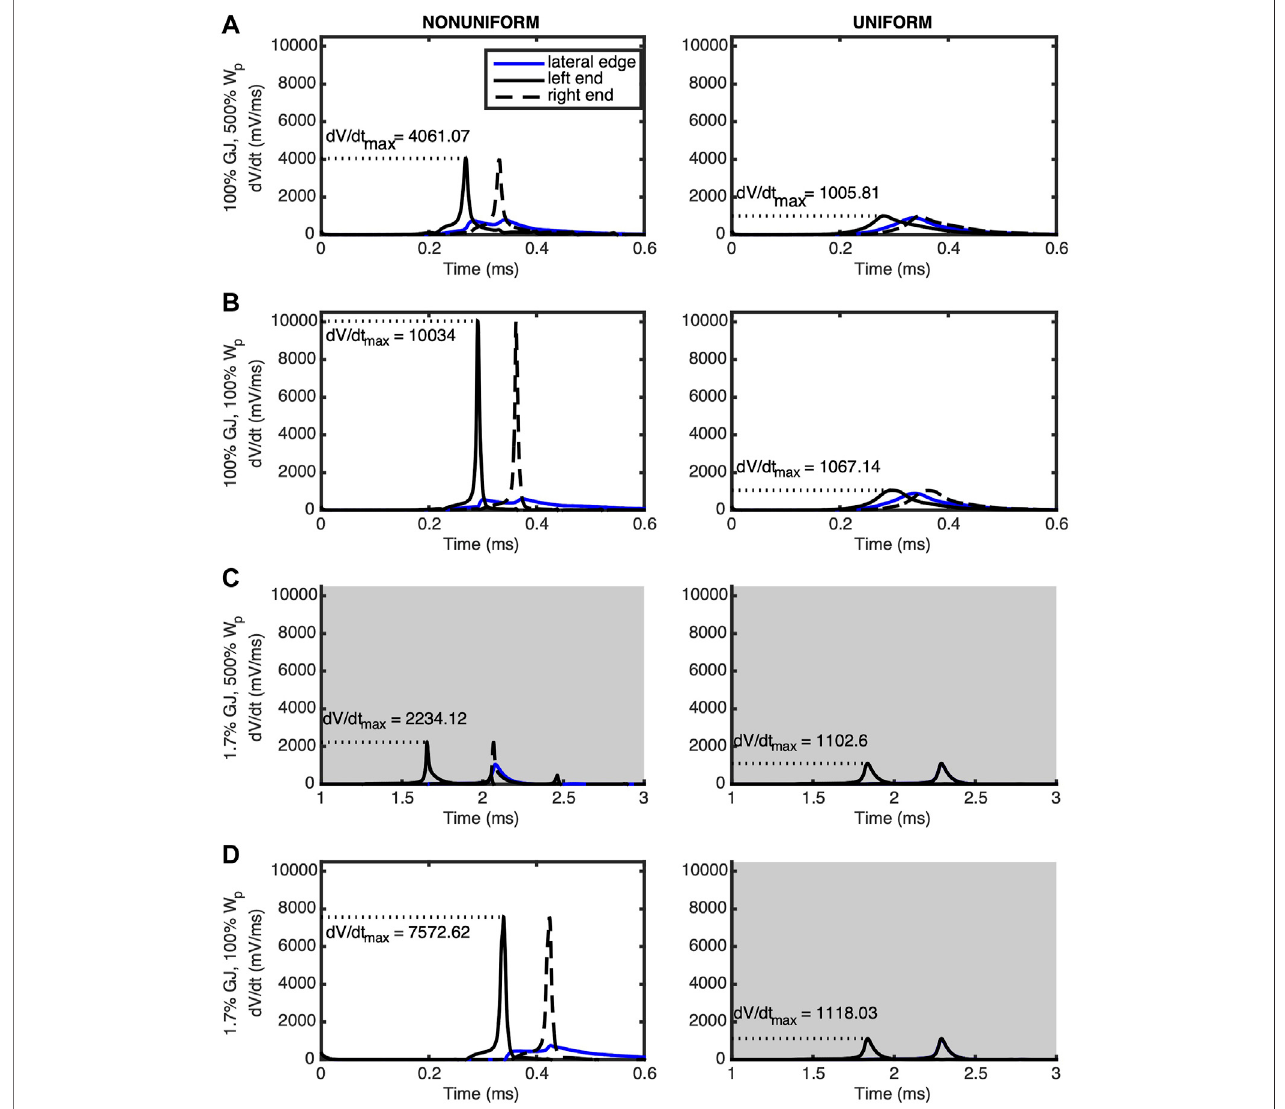
FIGURE 4 | The derivative of the transmembrane potential is plotted for the left (solid black) and right (dashed black) ends as well as the lateral midpoint (blue) of a cell undergoing an AP traveling from left to right. Panels are arranged in the same positions as those of Figure 1 . Left column (nonuniform) shows cells with sodium and potassium ion channels preferentially distributed at the ends of the cells. Right column (uniform) shows cells with ion channels evenly distributed over the surface of the cell. (A) ThewideW P casewascompared against tissue where (B) W p wasnominal, (C) GJ coupling wasreducedand W p waswide, and (D) W p wasnominal and GJ coupling reduced. In the nonuniform cases, dV/dt_max is more sensitive to W p compared to GJ coupling. Gray shading indicates panels having a longer time scale due to slower conduction